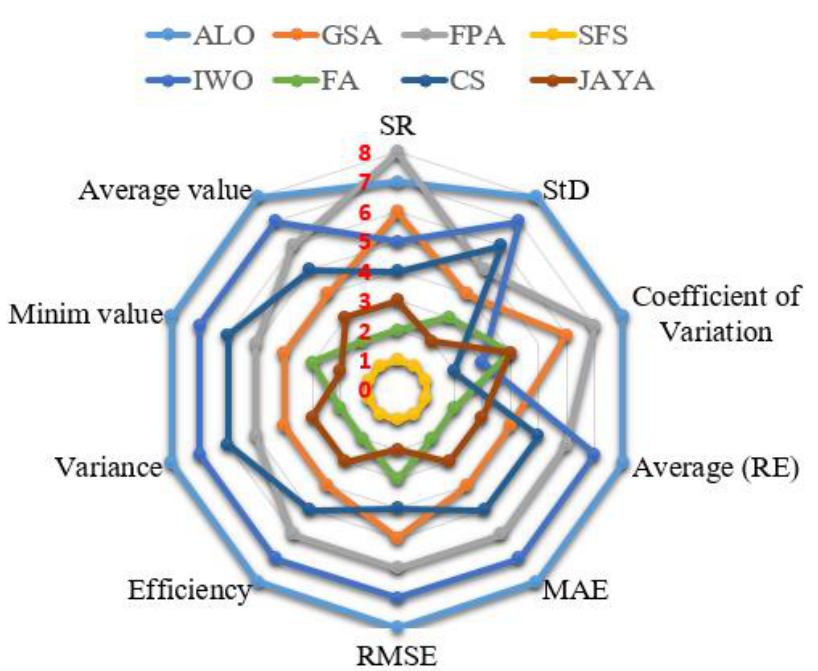
Figure 9. Radar plot for ranking considered global MPPT methods.